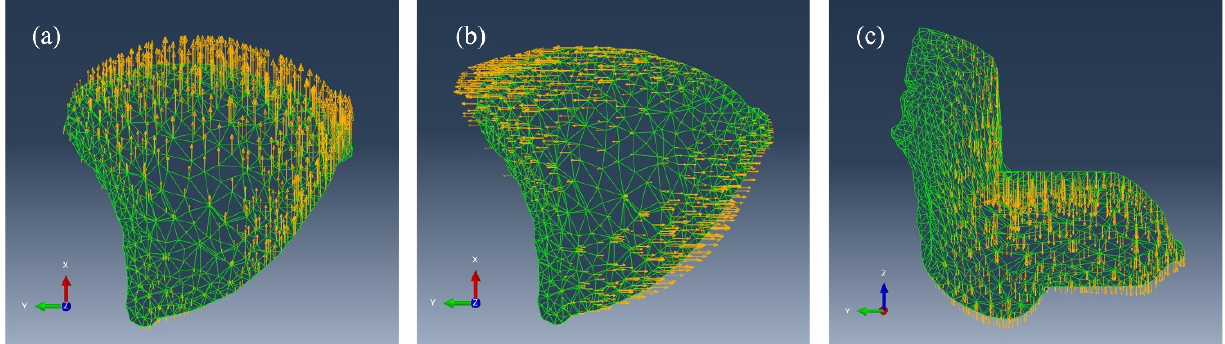
Figure 6. Node displacement of the left breast model: ( a ) medial–lateral direction and ( b ) anterior– posterior direction in the axial plane at 2 cm from the compression paddle, and ( c ) CC direction in the sagittal plane through the nipple. The length of the arrows represents the magnitude of displace- ment.